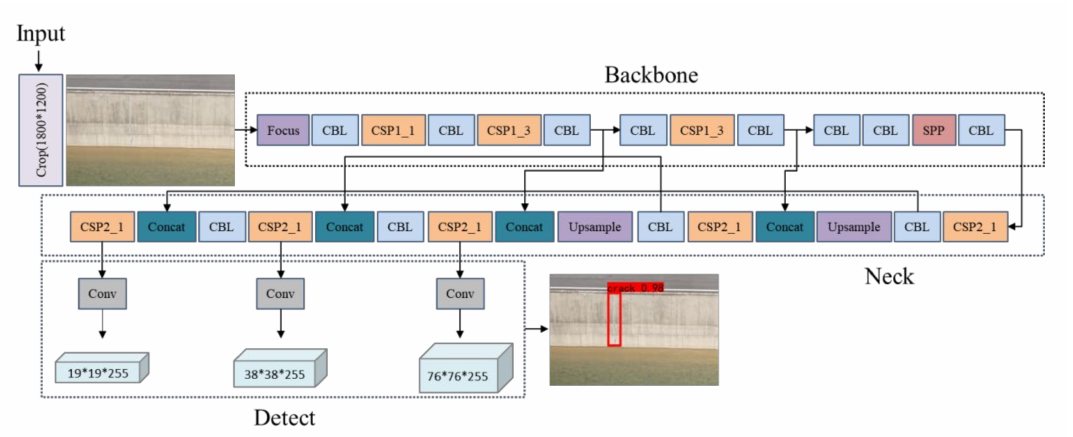
Figure 5. YOLO v5s network structure diagram.